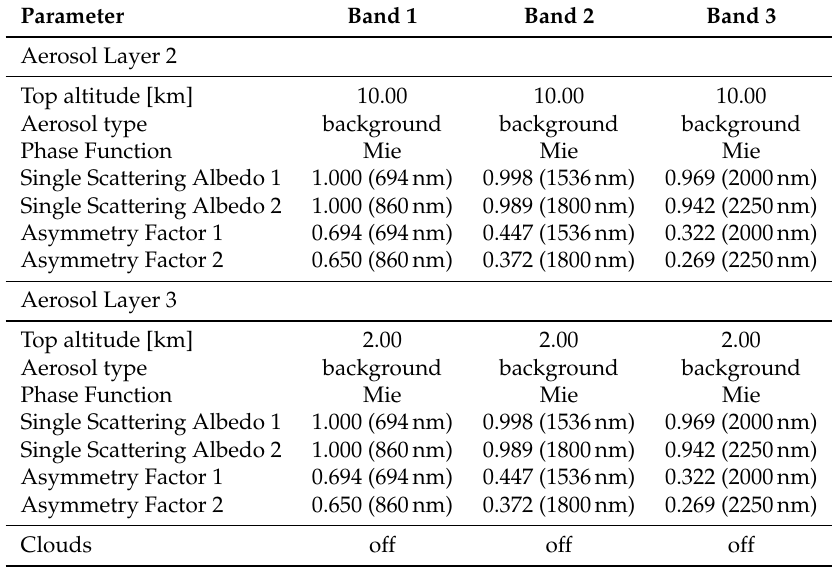
Table A8. Scattering parameters of scenario Rayleigh+Aerosol BG